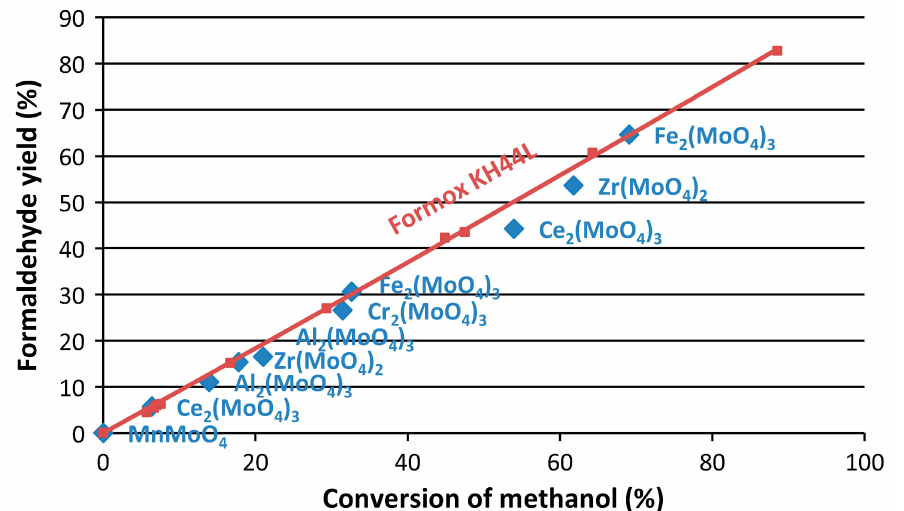
Figure 22. Comparison of catalyst performance of various molybdates to the Formox KH44L com- mercial catalyst showed as yield vs. conversion. T = 300 ◦ C. Feed: 6 vol.% MeOH and 11 vol.% O 2 in inert gas. Flow: 227–277 mL/min. Catalyst loading: 25–1000 mg catalyst (surface area of catalyst 0.1–3 m 2 ). Particle size: 0.215–0.425 mm. Reprinted with permission from [6] Springer, Topics in catalysis, Copyright © (2016).